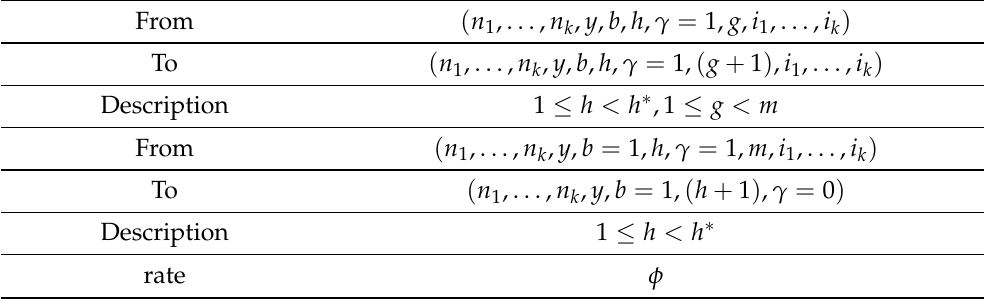
Table 4. An Erlang distribution with m states and parameter φ .